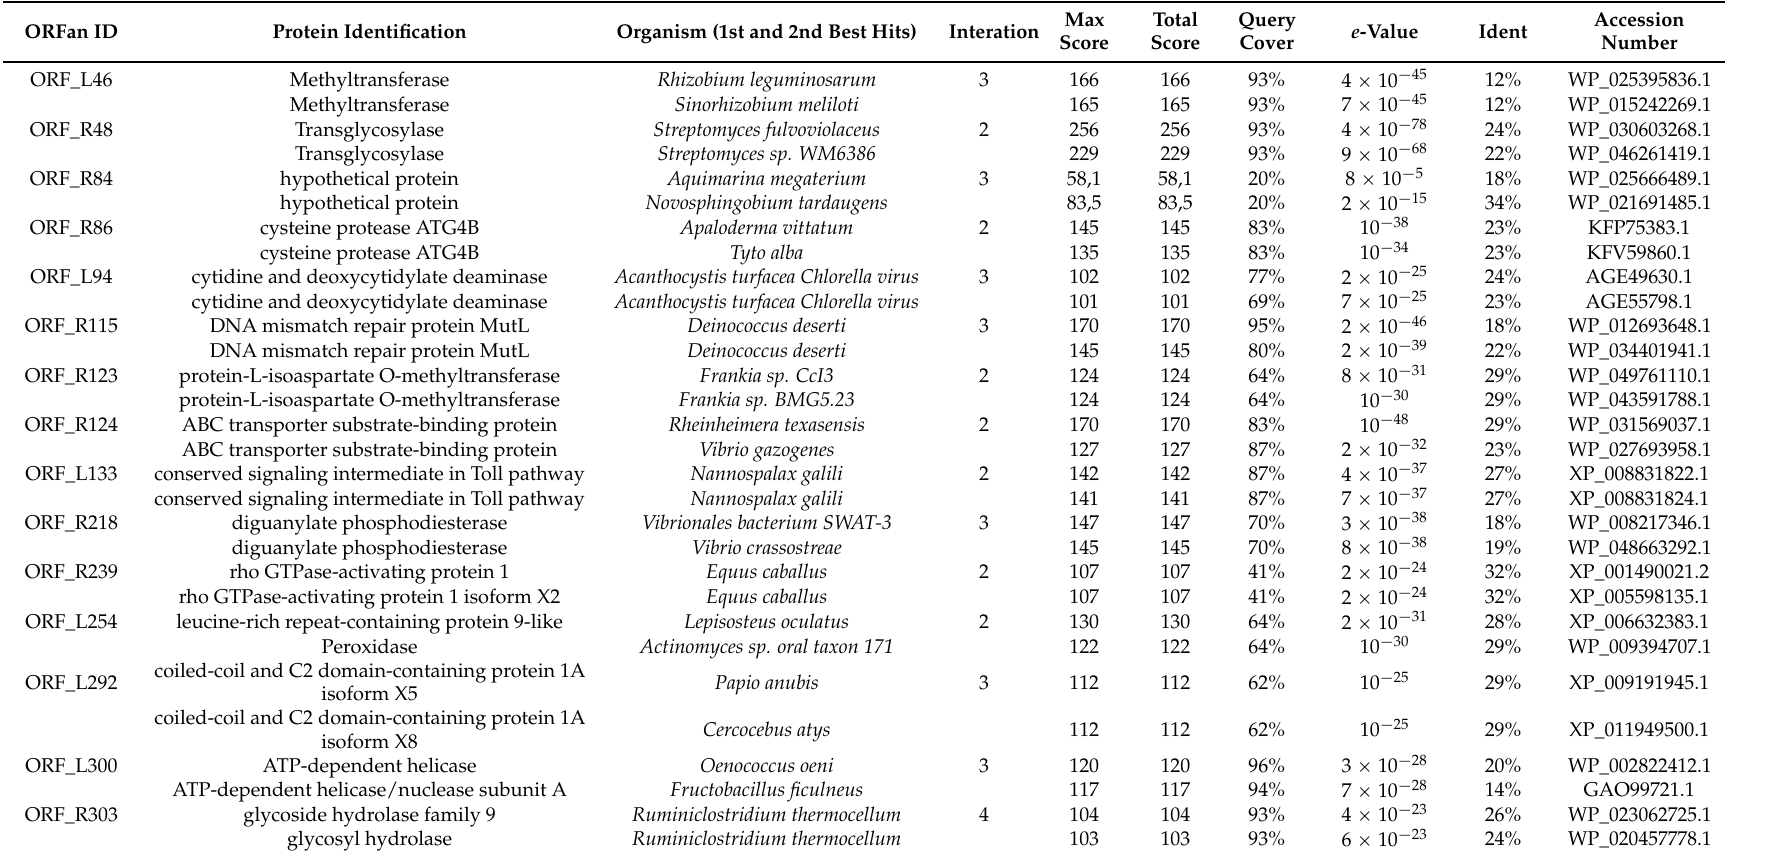
Table 1. Analysis of Brazilian Marseillevirus ORFans by Position-Specific Interative Basic Local Alignment Search Tool (PSI-BLAST)—ORFs with no significant similarity found are not